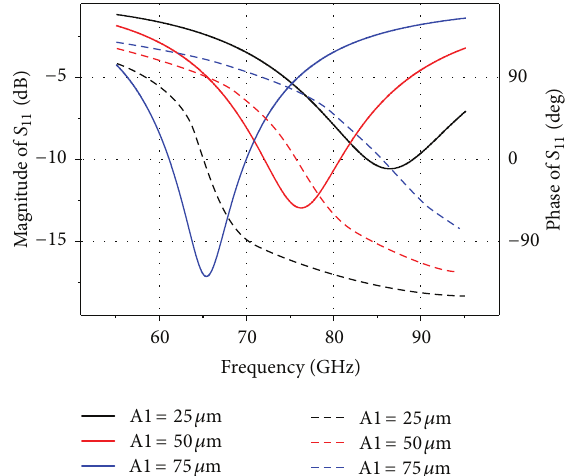
Figure 5: Magnitude and phase of reflection coefficient versus geometrical parameter